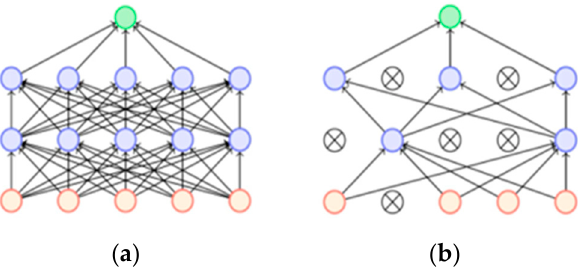
Figure 2. Dropout neural network. ( a ) A traditional network with two hidden layers; ( b ) An instance of a thinned network. Crossed nodes have been dropped.